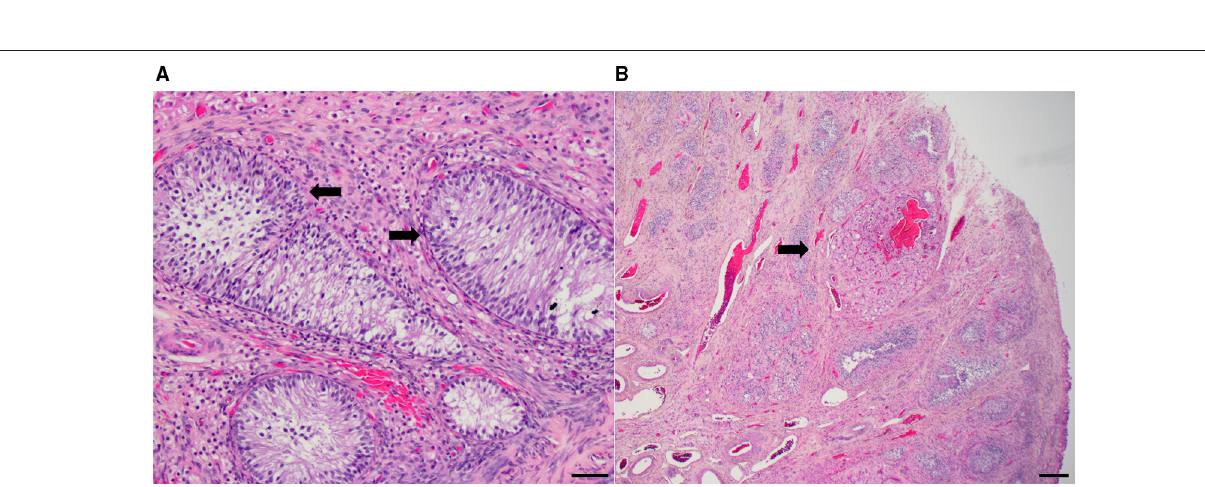
FIGURE 2 | (A) Ovary with granulosa cell hyperplasia (arrows) (H&E stain; bar = 20 microns). (B) A single corpus luteum (arrow) (H&E stain, bar = 200 microns).